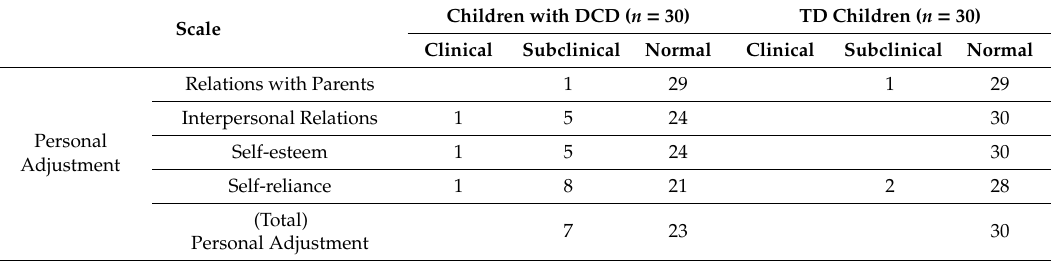
Table 5. Clinical, subclinical, and normal level distribution of participants in behavioral problem.